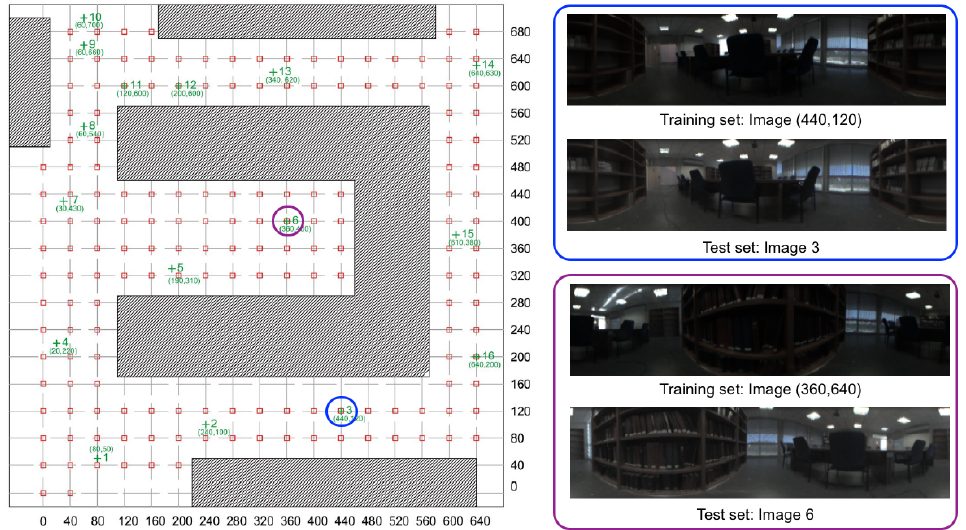
Figure 3. Library. Bird’s eye view of the capture points of the training set of images. The size of the grid is 40 × 40